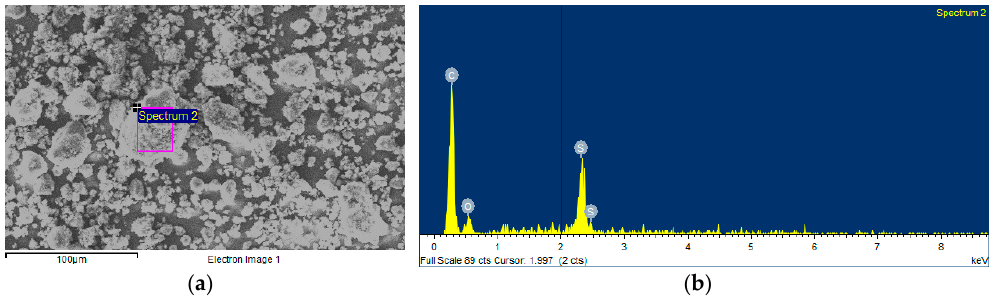
Figure 2. EDS microanalysis of sulfonic acid-functionalized graphene nanoplatelets: ( a ) studied area; ( b ) EDS spectrum.